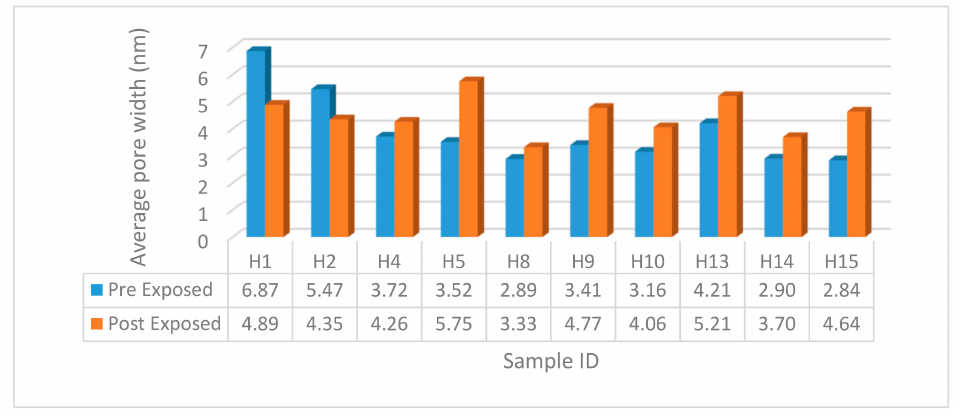
Figure 6. Histogram showing the average pore size of the analysed